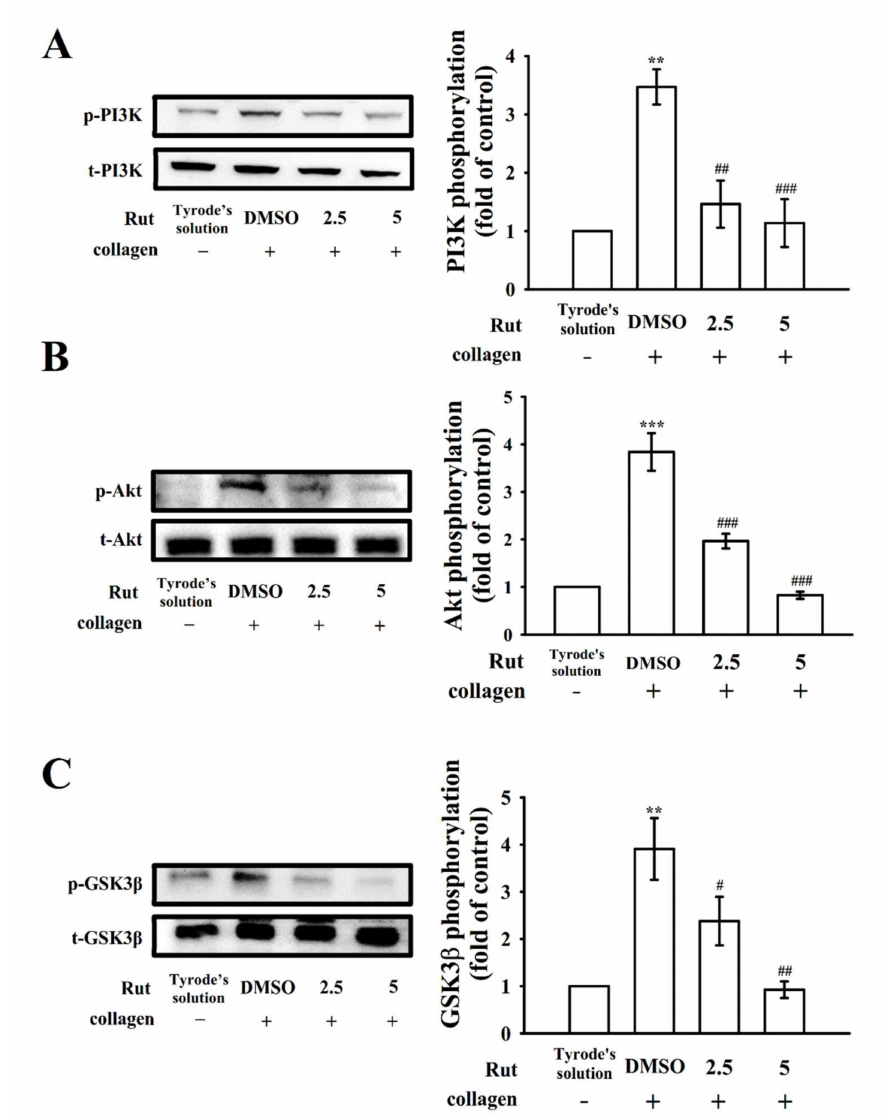
Figure 5. Effectiveness of Rut in PI3K/Akt/GSK3 β phosphorylation in platelets. Washed platelets were preincubated with 0.1% DMSO or Rut (2.5 and 5 µ M) and then treated with collagen (1 µ g/mL) for immunoblotting ( A ) PI3K, ( B ) Akt, and ( C ) GSK3 β phosphorylation. Data are expressed as the mean ± standard error of the mean ( n = 4). ** p < 0.01 and *** p < 0.001 compared with the resting control; # p < 0.05, ## p < 0.01, and ### p < 0.001 compared with the 0.1% DMSO-treated